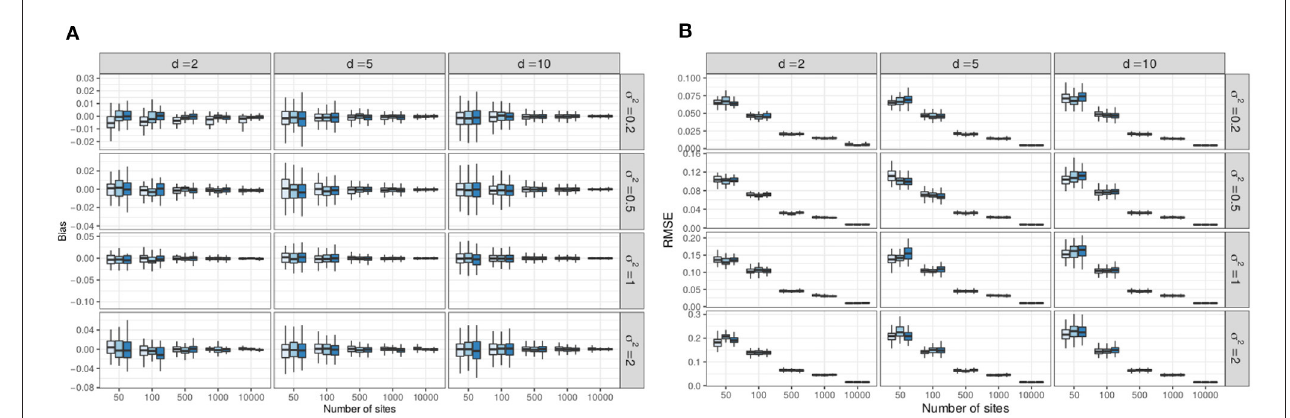
FIGURE 7 | Result of the simulations: variational estimates are unbiased and have low RMSE starting at n (A) Empirical bias of the variational estimates darker: lower to higher). (B) Empirical RMSE of the variational estimates sampling effort (lighter to darker: lower to